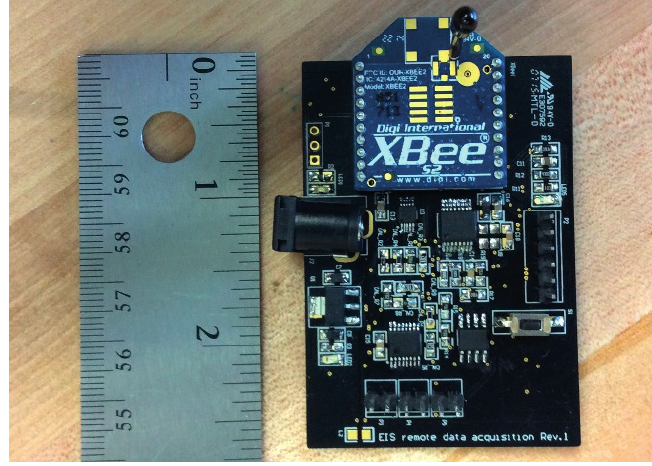
Figure 3. Picture of the wireless Dielectric Impedance Spectroscopy (DIS)